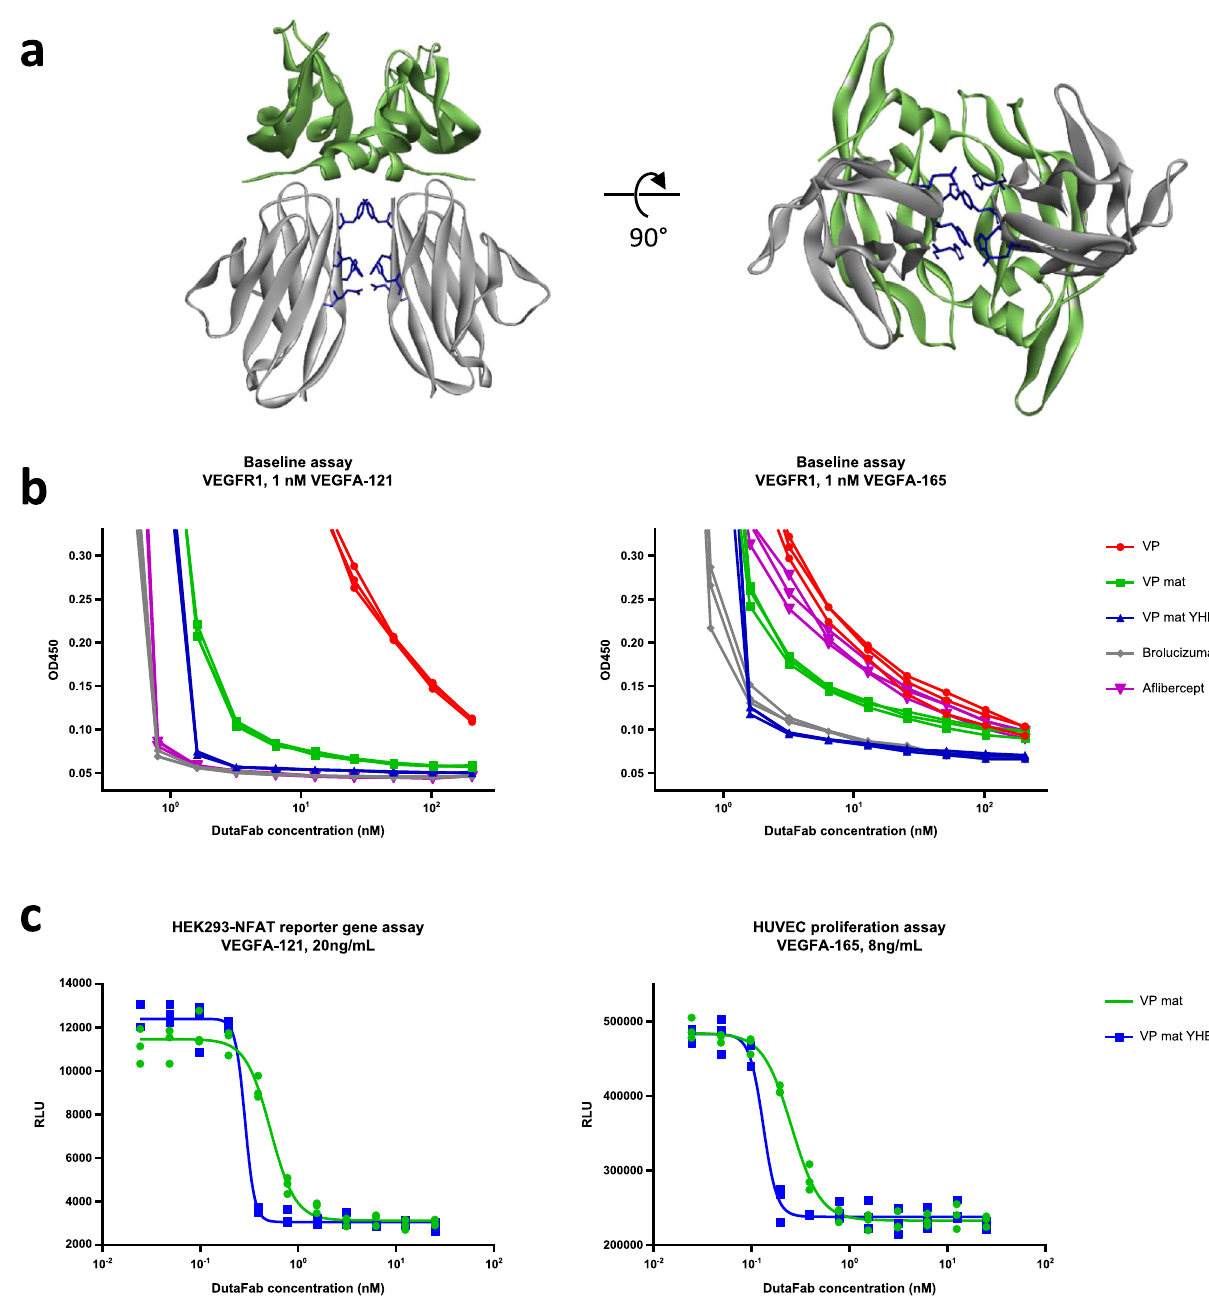
Fig. 5 Structure-based engineering of VEGF potency. a Side-view and bottom-view of the YHE co-operativity motif engineered into the Vk domain of the VP mat DutaFab. For clarity only the Vk domains (gray) are presented in complex with VEGF dimer (green). Residues involved in co-operative Fab binding are shown as blue sticks. Positions of sidechains have been modeled in silico using the Discovery Studio modeling suite based on the crystal structure of a DutaFab containing the co-operativity motif that is not presented in this study. b VEGF baseline assay with both VEGFA-121 and VEGFA-165 isoforms, showing complex stability of the VEGF dimer, fully blocked on both receptor binding epitopes by drug molecule. A low signal indicates complete blocking of the VEGF dimer. A high signal far away from baseline shows that a large fraction of VEGF has lost the blocking drug during the incubation with the competing receptor. The signal in fl ection seen at 1 nM drug paratope concentration is due to stoichiometric limitation. c HEK293-NFAT reporter gene assay and HUVEC proliferation assay with and without co-operativity motif. A sample size of n = 3 independently prepared samples was used in the experiments shown in panels b and c